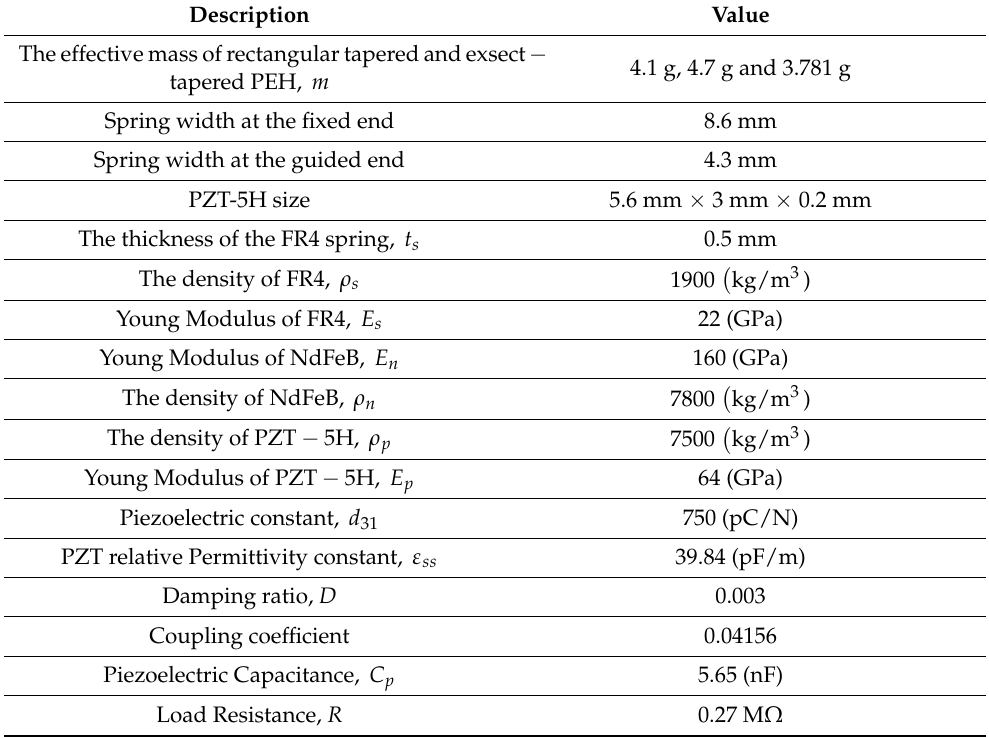
Table 1. Material properties and parameters of the nonlinear PEH.